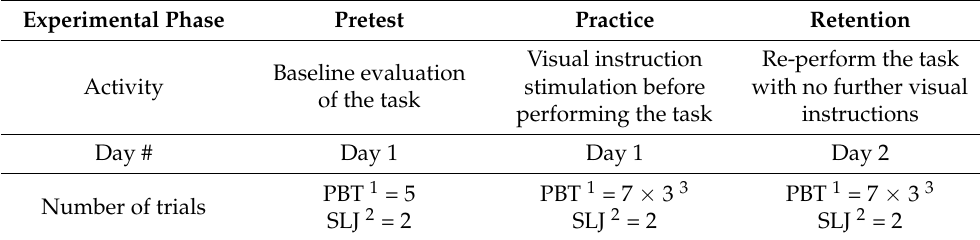
Table 3. Timeline of the experiment. Experimental